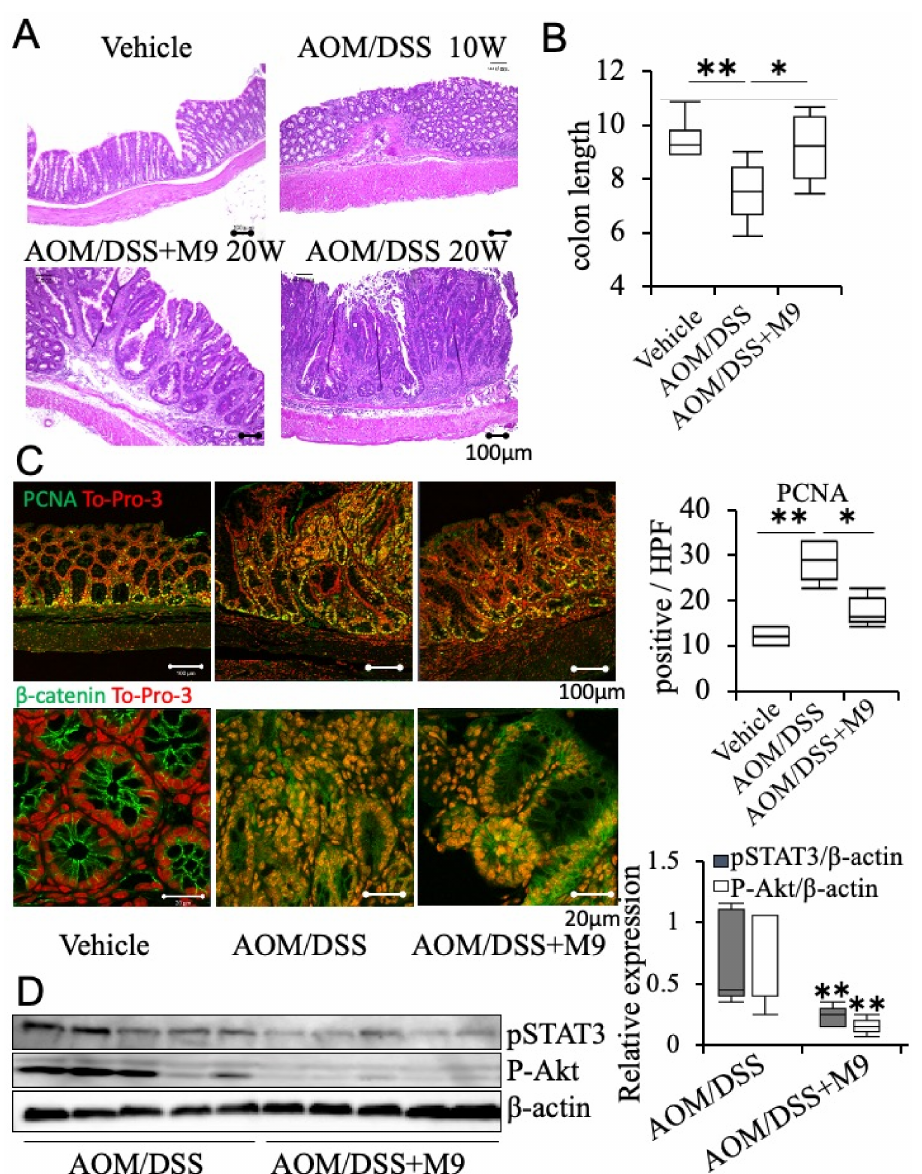
Figure 2. Treatment with Probio-M9 ameliorated AOM/DSS-induced tumorigenesis. ( A ) Represen- tative images of colon morphology, total number of tumor, and estimated tumor size per mouse. ( B ) Statistics of colon length. n = 10. ( C ) Representative image of immunohistochemistry staining for proliferating cell nuclear antigen (PCNA) in tumor areas. Positive cell number in the mucosa per high power field (HPF: 0.196 mm 2 ) was counted and summarized in graphs. n = 5. Representa- tive image of immunohistochemistry staining for β -catenin in vehicle intestine and tumor areas of AOM/DSS, and AOM/DSS+M9. To-Pro-3 was used to label the nucleus. ( D ) Representative image of immunoblotting experiments for p-STAT3 and p-Akt. β -Actin was used as an internal control. Results are summarized in graphs. n = 5. * p < 0.05; ** p < 0.01. scale bar: 100 µ